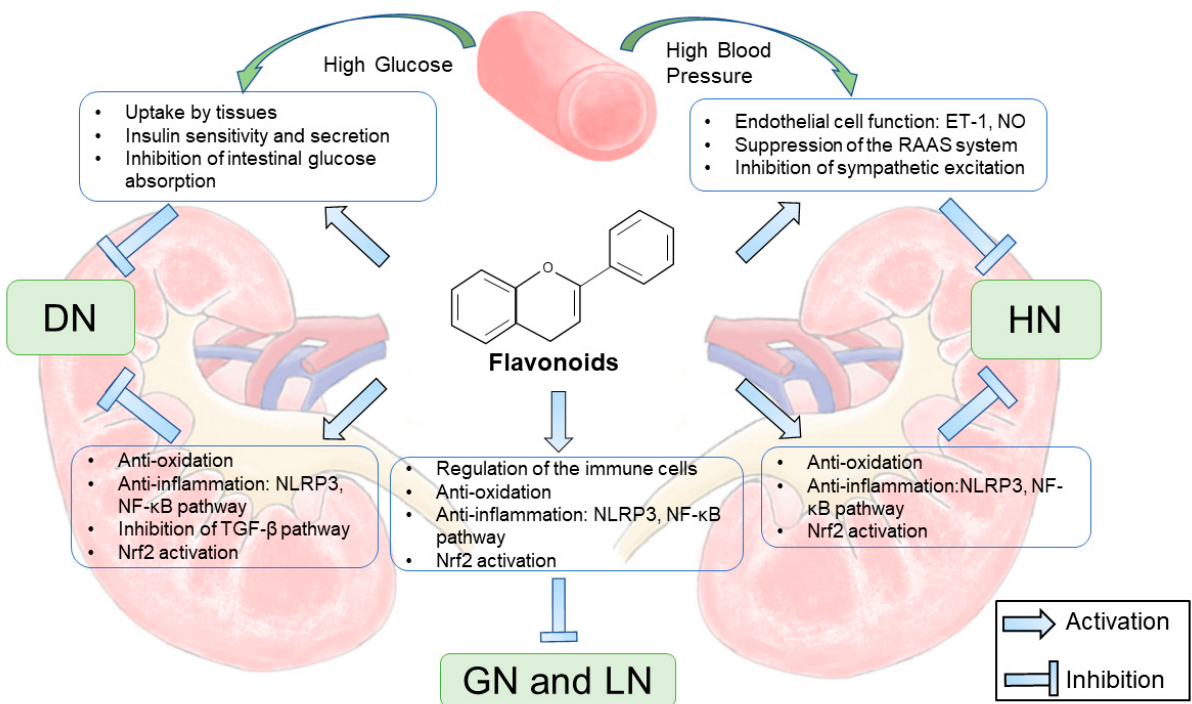
Figure 3. The nephroprotective mechanisms of flavonoids in CKD.